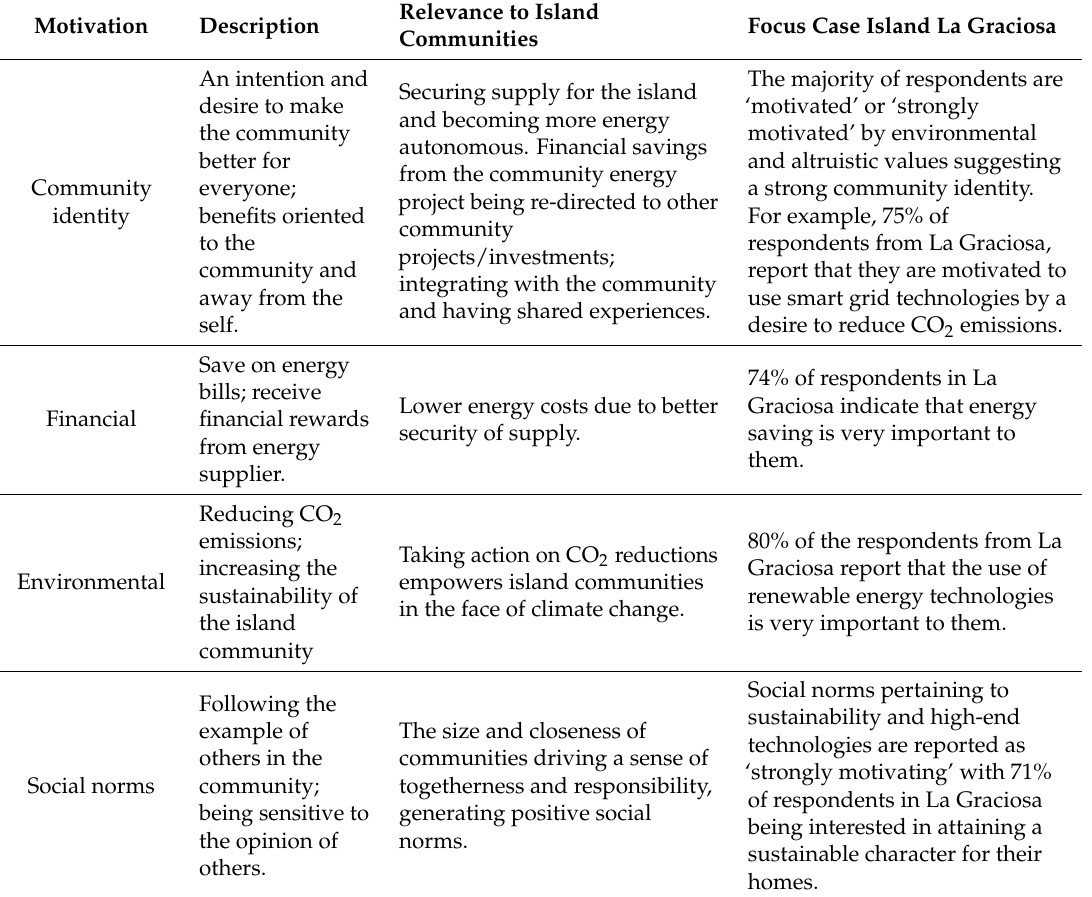
Table 2. Motivations for participation in island sustainable energy projects in island communities and findings from a survey conducted in La